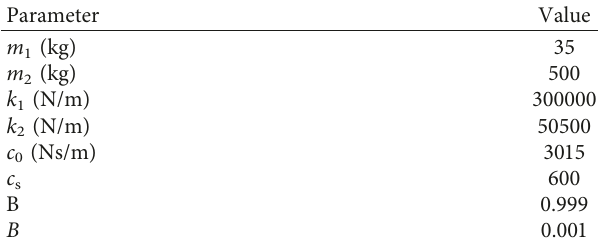
Table 1: Parameters needed in this research.